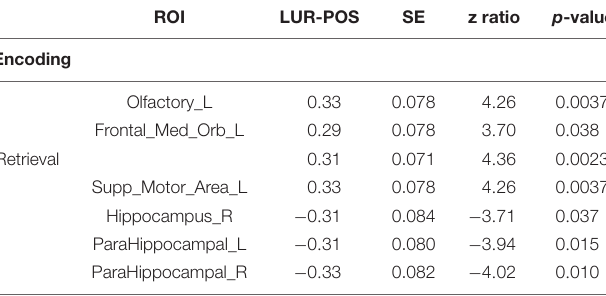
TABLE 2 | Estimated means’ interaction correlation × phase × probe × ROI in the global processing task, averaged over condition levels.